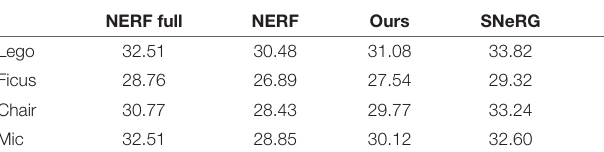
TABLE 1 | PSNR-scores on holdout views of scenes from the NERF synthetic data set for original NERF, NERF without view-dependence, our method, and SNeRG.